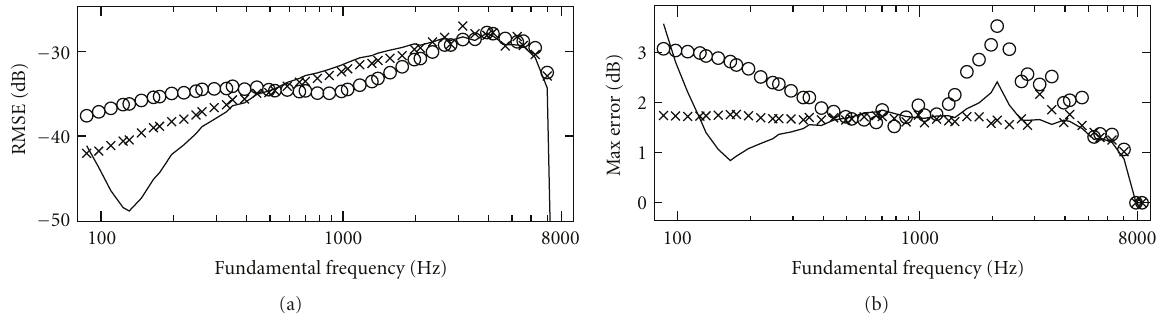
Figure 13: (a) RMSE and (b) the maximum absolute harmonic magnitude error of the filtered fourth-order B-spline BLEP sawtooth oscillator using the polynomial approximation of the filter parameters (solid line), the estimated parameters (crosses), and a fixed filter that has the parameters estimated for the fundamental frequency of 524Hz